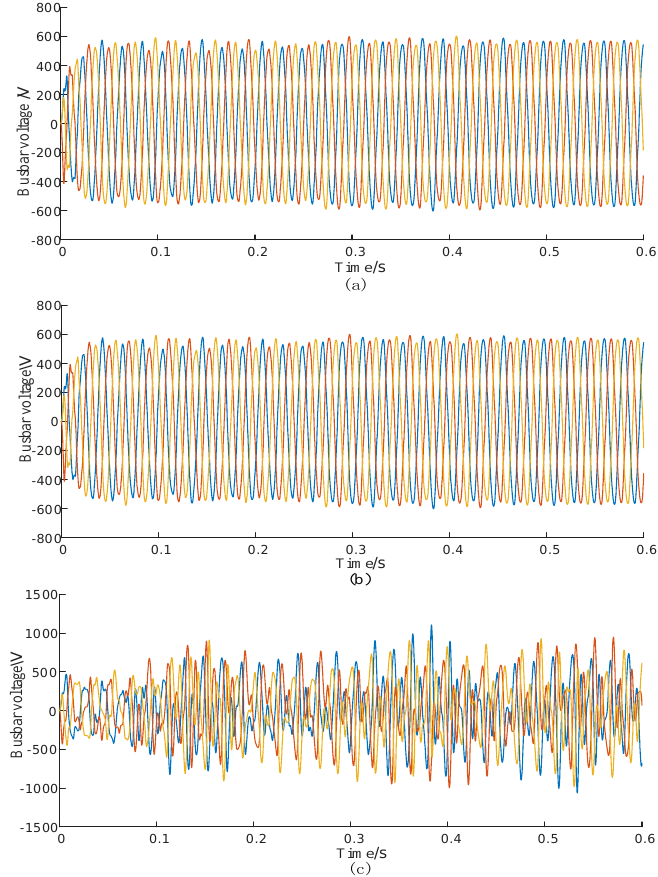
Figure 2. Waveforms of bus voltage under different working conditions in case of ( a ) DG1 and DG3 running; ( b ) DG2 and DG3 running; ( c ) DG1, DG2 and DG3 running together.